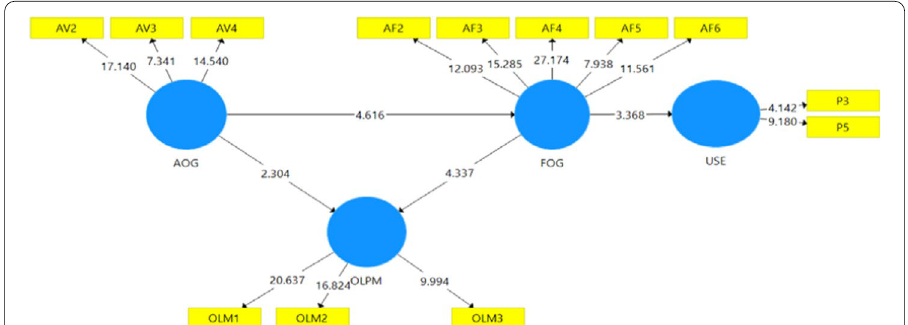
Fig. 4 Results of Bootstrapping obtained for path analysis. Source : Field survey (2021)